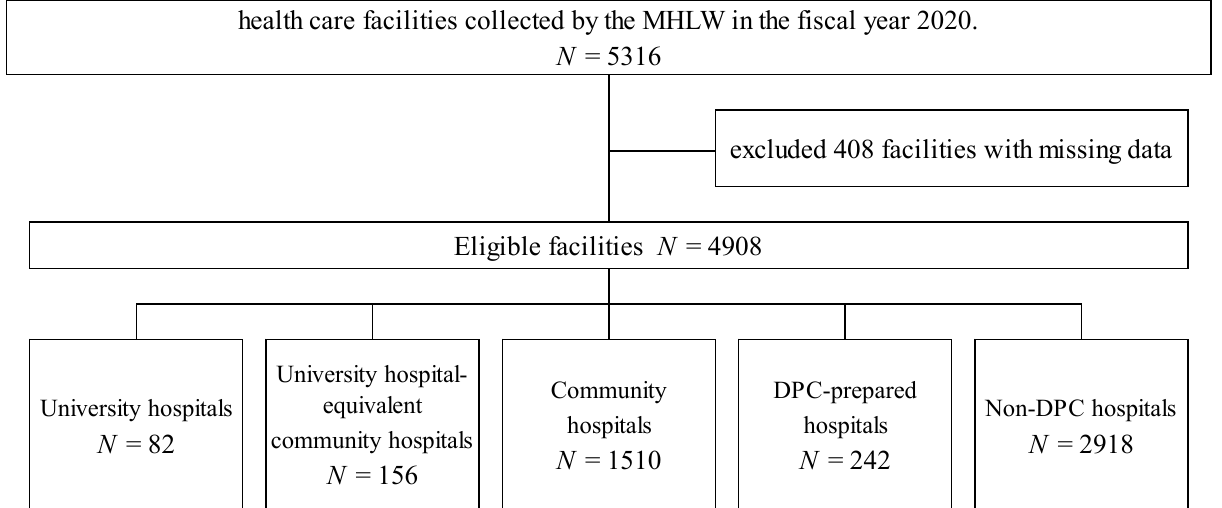
Figure 1. Study flow diagram showing the stratification and selection of patients in the Diagnosis Procedure Combination database by the Ministry of Health and Welfare in the fiscal year 2020. Table 1. Characteristics of hospitals stratified by facility type.